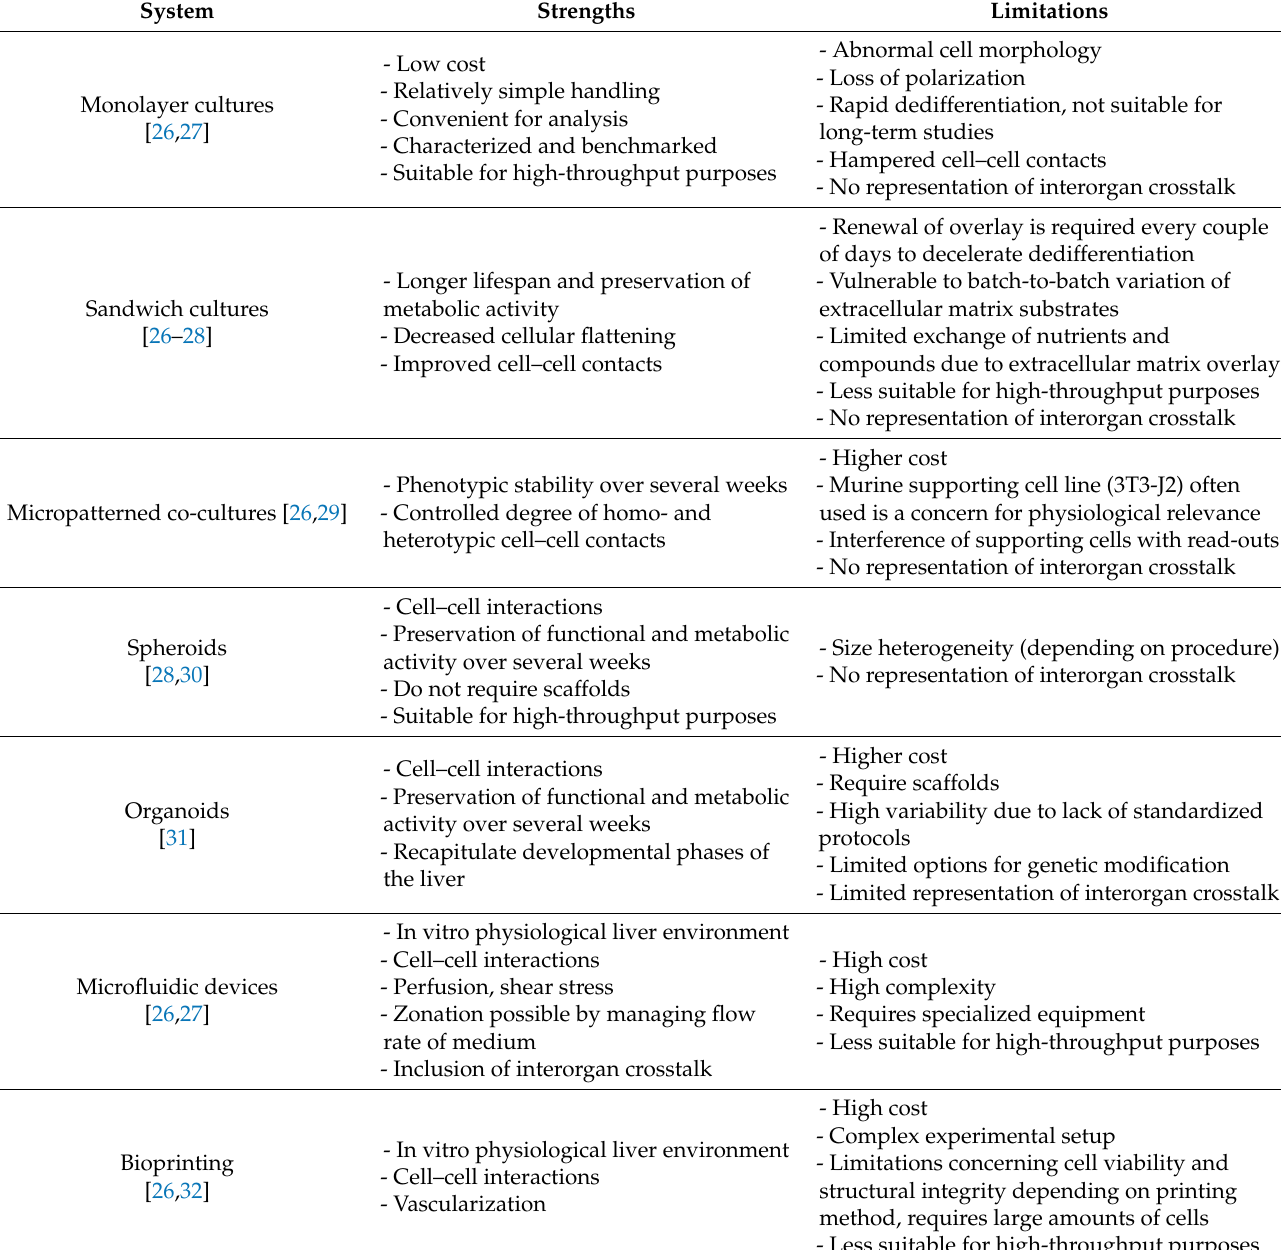
Table 2. Strengths and limitations of cell culture systems for hepatic in vitro